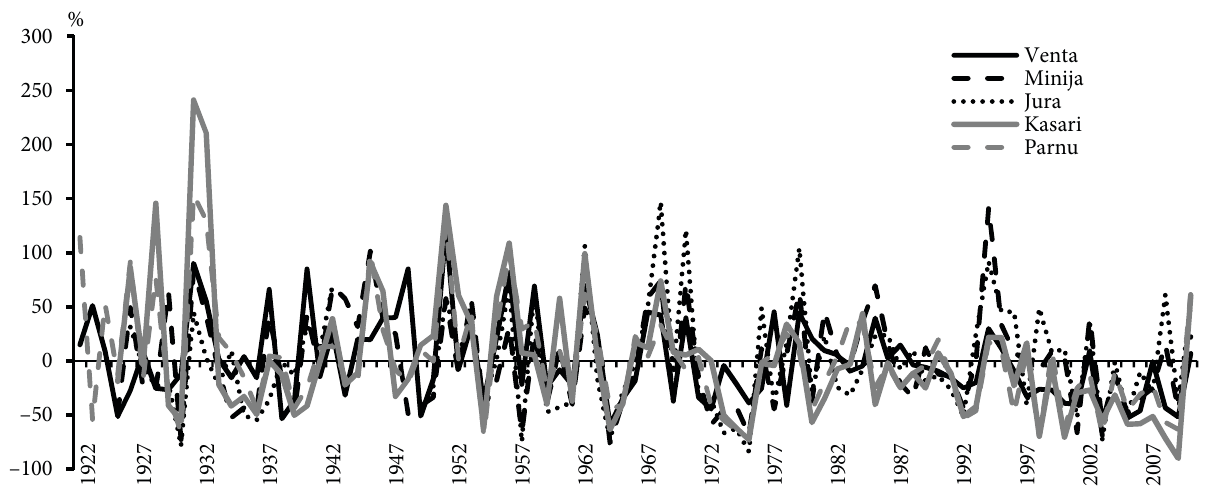
Fig. 3. Annual maximum spring flood anomalies (%) from the long-term average in the marine rivers